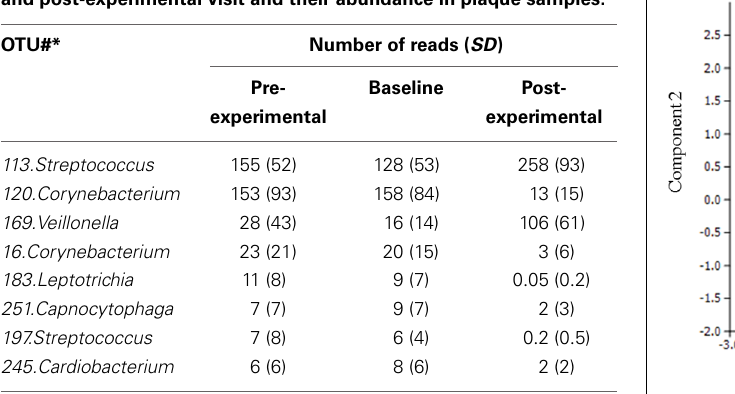
and post-experimental visit and their abundance in plaque samples.